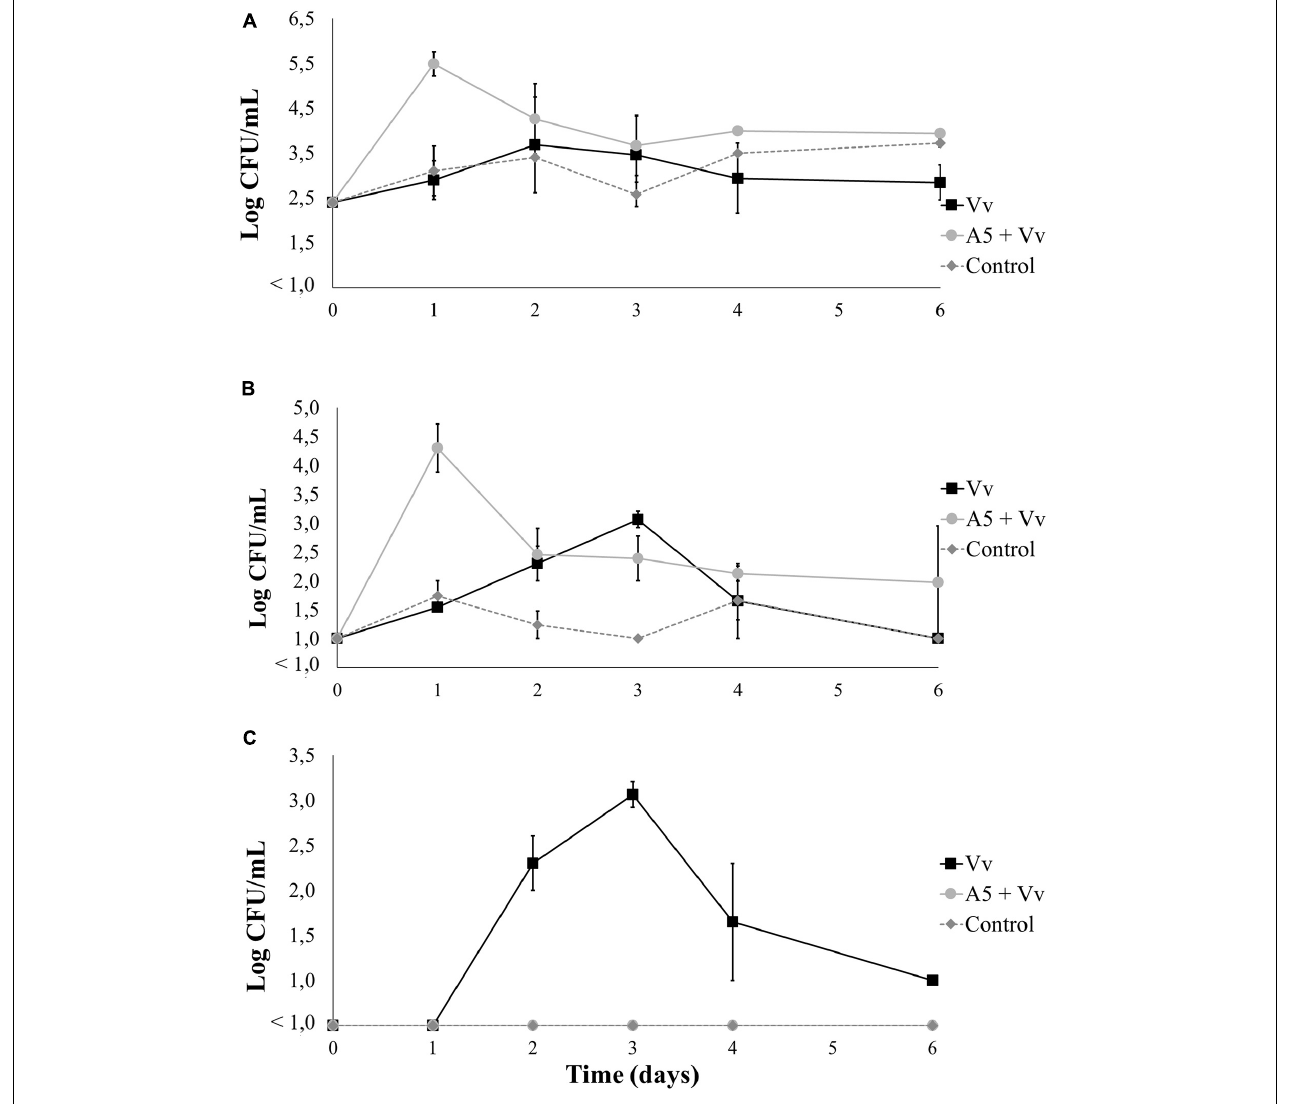
FIGURE 9 | Total aerobic bacteria (A) , total vibrio (B) , and Vibrio vulnificus (C) levels in seawater from bioassay 3 (inoculation with A5 prior to inoculation with V. vulnificus ). Three treatments are shown: Vv inoculated with V. vulnificus only ( (cid:4) ), A5 + Vv first inoculated with A5 and then with V. vulnificus ( • ), and control ( (cid:7) dotted line). The absence of colonies is represented as below the limit of detection (LOD) ( < 1.0 log